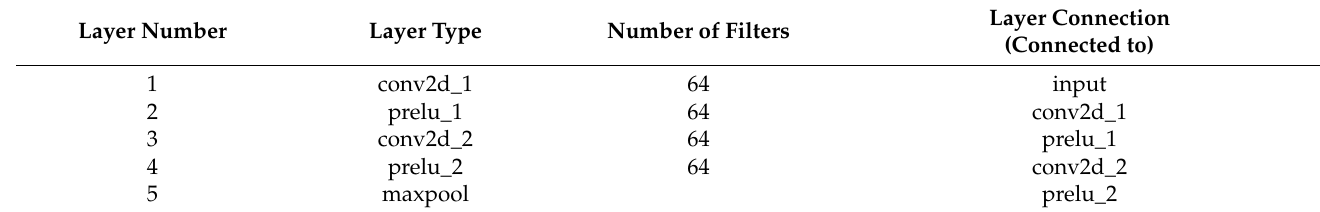
Table 4. Description of an encoder block of the generator.